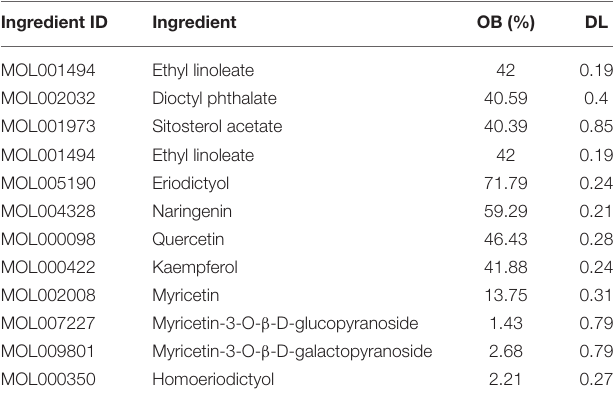
TABLE 1 | Information of bioactive components of L. aureum